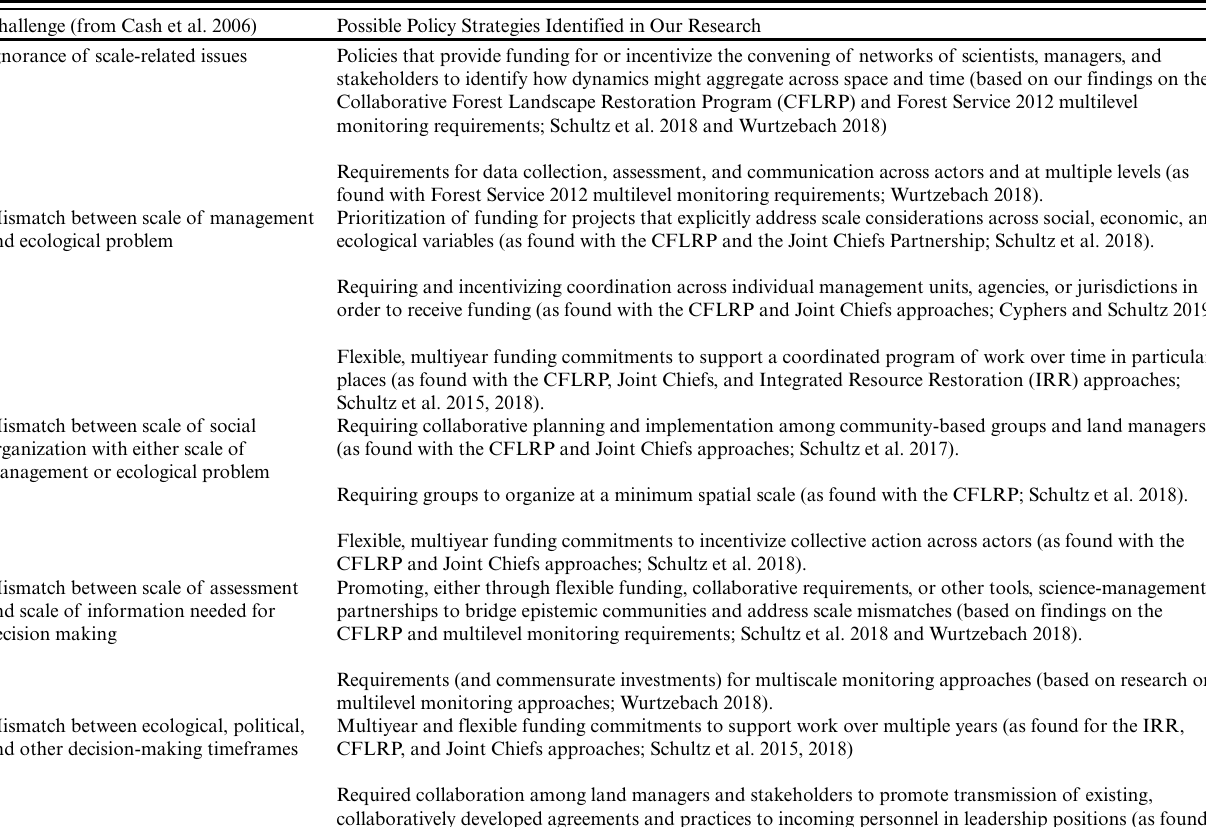
Table 3 . Types of scale challenges and potential policy